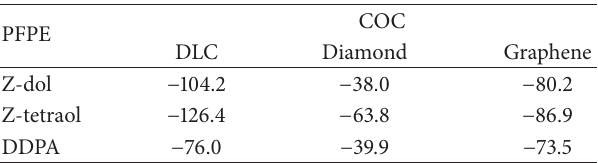
Table 4: Counterpoise corrected interaction energies for